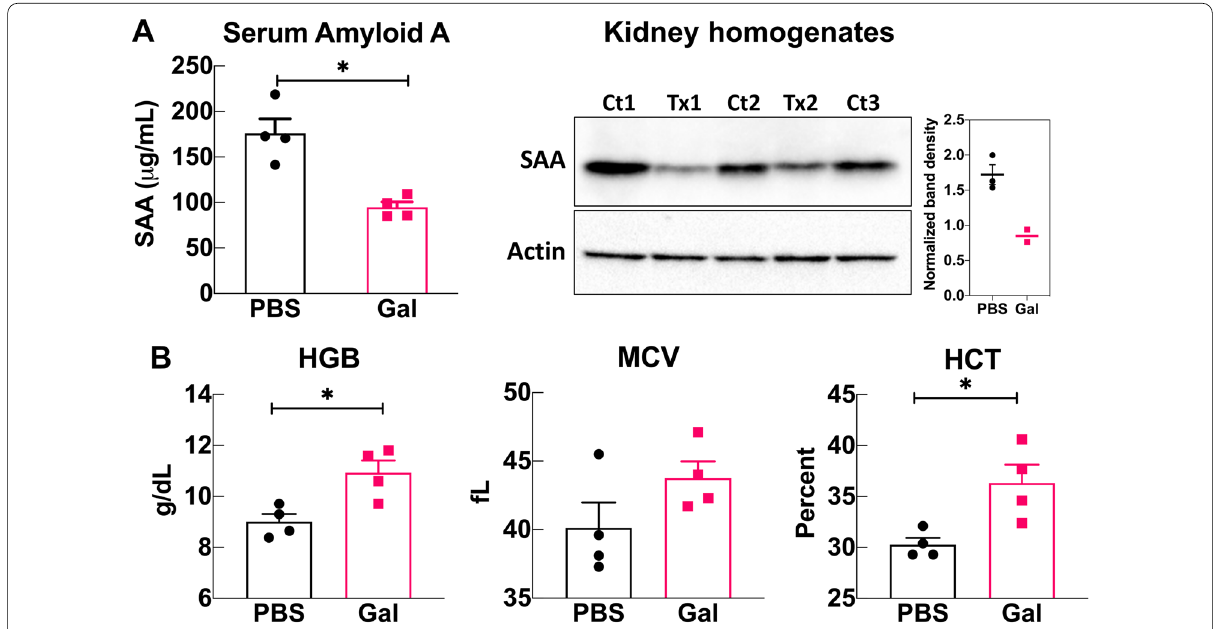
Fig. 3 Galantamine lowers markers of chronic inflammation in FMF‑KI mice. A Serum (left panel) and kidney deposited (right panel) SAA. Kidney homogenates from galantamine‑treated (Tx) and PBS‑treated (Ct) FMF‑KI mice were probed for SAA deposition after 8 weeks of treatment. Band density was quantified with ImageJ and normalized by actin. B Hemoglobin (HGB), mean corpuscular volume (MCV), and hematocrit (HCT) levels in galantamine‑ and PBS‑treated FMF‑KI mice at the end of 8 weeks of treatment (data presented as mean Whitney U